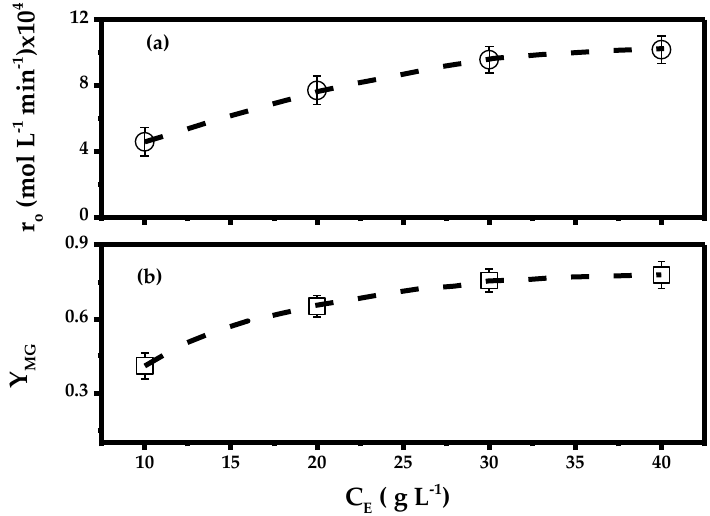
Figure 1. Effect of enzyme concentration on initial rate of esterification of ibuprofen T = 70 °C, C I0 = 60 g·L −1 , N = 720 rpm over the initial reaction rate ( a ) and monoglyceride yield ( b ).